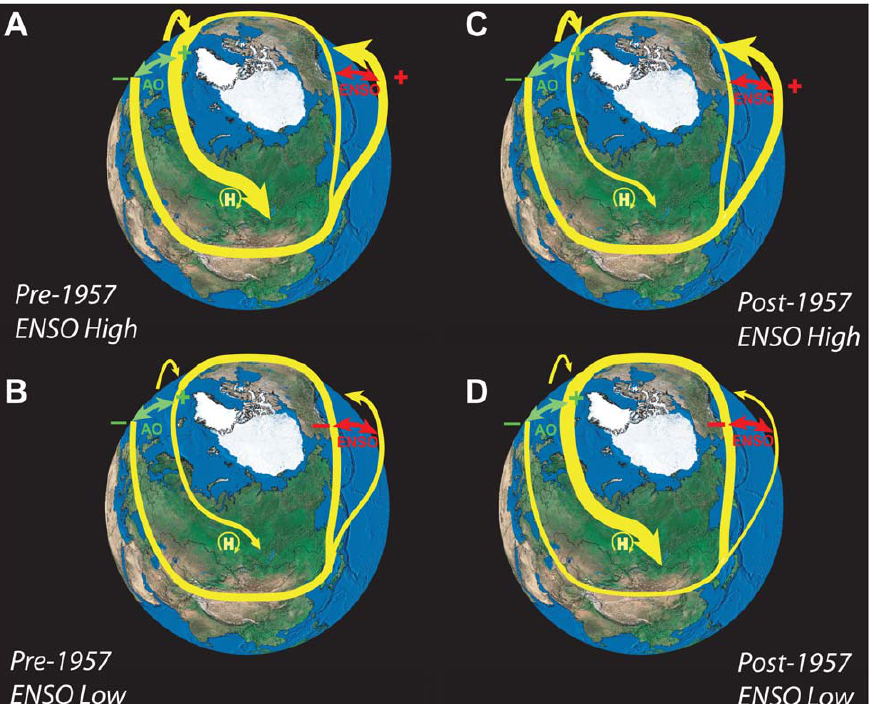
Figure 6. Suggested interaction between ENSO and AO affecting jet stream (JS) trajectories (yellow) over central Asia in the periods before 1957 and from 1957–2003 (C&D) during PDO ‘‘cool’’ phases. Prior to 1957 positive variations in ENSO (red arrow), correlated with stronger, persistent lower latitude sub-tropical JS flow and less energy driven up into the polar jet across the Pacific (A&B). These conditions were positively correlated with W ( t ,40) because of strong, northerly polar JS into central Asia consequent to positive AO values (green arrows). In periods of low ENSO values, the converse would prevail, with JS flow diverted higher latitudes on exit from the Asian Far East. In the period following 1957, AO and ENSO are out of phase and negative values of ENSO are associated with more energy pushed to higher latitudes across the Pacific and more variable, stronger polar jets arriving at the Atlantic. These periods are correlated with lower AO indexes and minimal additional energy pushed to higher latitudes and stronger flow arriving in central Asia, with the converse in periods of low ENSO index. In either case, (high-AO pre-1957, low- ENSO post-1957) strong polar JS flow arriving at the Siberian high (H) is diverted in an anti-cyclonic direction across Lake Baikal producing more negative W (t,40), colder fall water temperatures and earlier winter conditions.